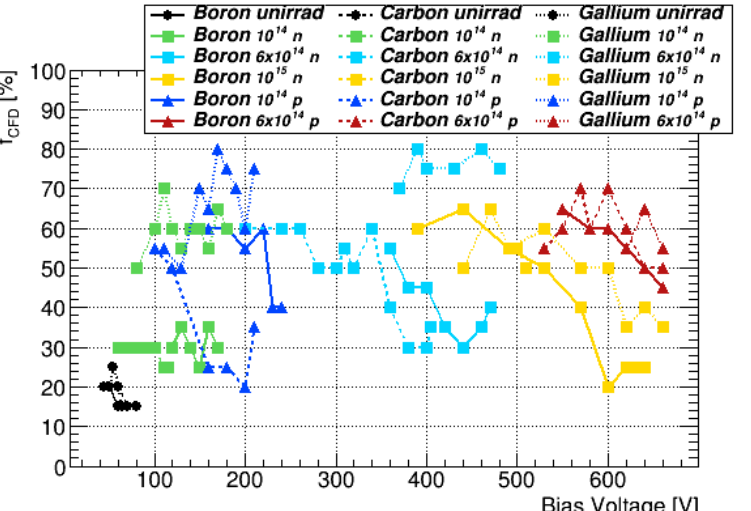
Figure A3. CFD fraction as a function of the bias voltage for CNM LGADs irradiated up to a fluence of 10 15 n eq /cm 2 at −